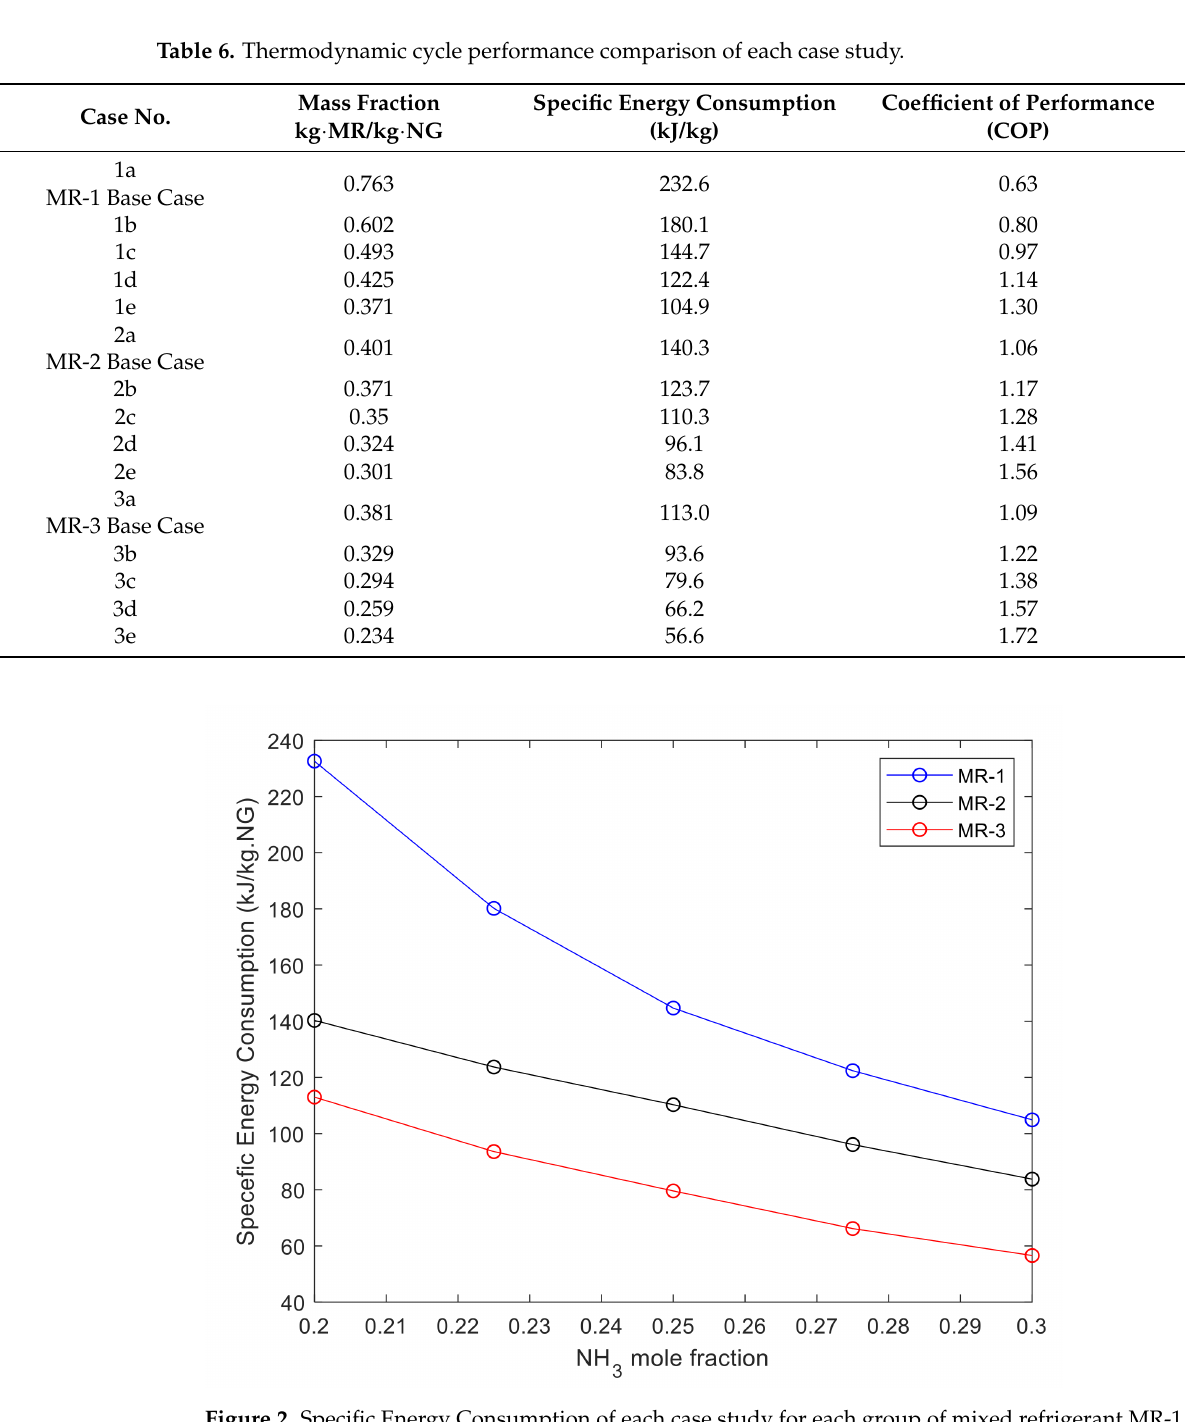
Figure 2. Specific Energy Consumption of each case study for each group of mixed refrigerant MR-1, MR-2 and